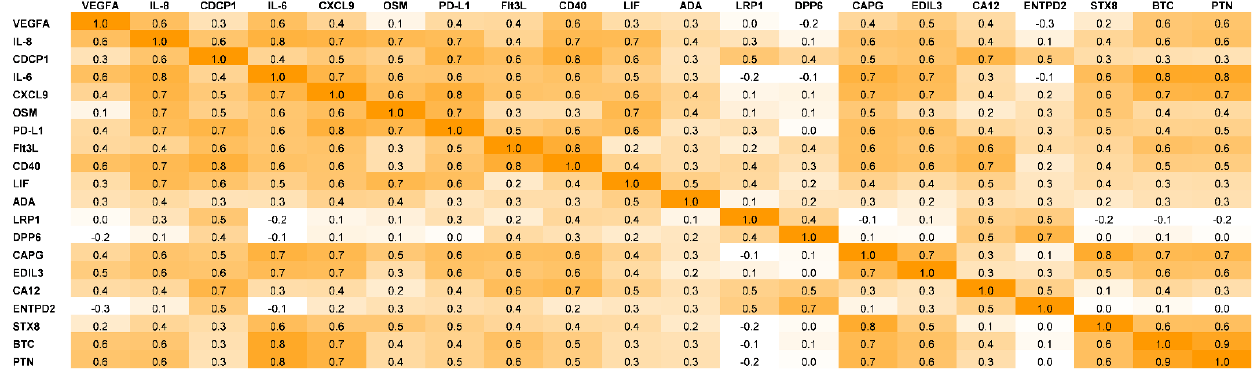
Figure 4. Correlation matrix of raised markers in deceased COVID-19 patients. Pearson’s correlation coefficient is a statistical measure that expresses the strength of a linear relationship between two paired sets of data. The background colours mark the value of the coefficient (orange is significant but white is non-significant); the positive correlation between paired data is “0.8 ≤ r ≤ 1.0 = very strong”, “0. 6 ≤ r ≤ 0.79 = strong”, “0.4 ≤ r ≤ 0.59 = moderate”,” 0.20 ≤ r ≤ 0.39 = weak”, and “0.0 ≤ r ≤ 0.19 = very weak”.